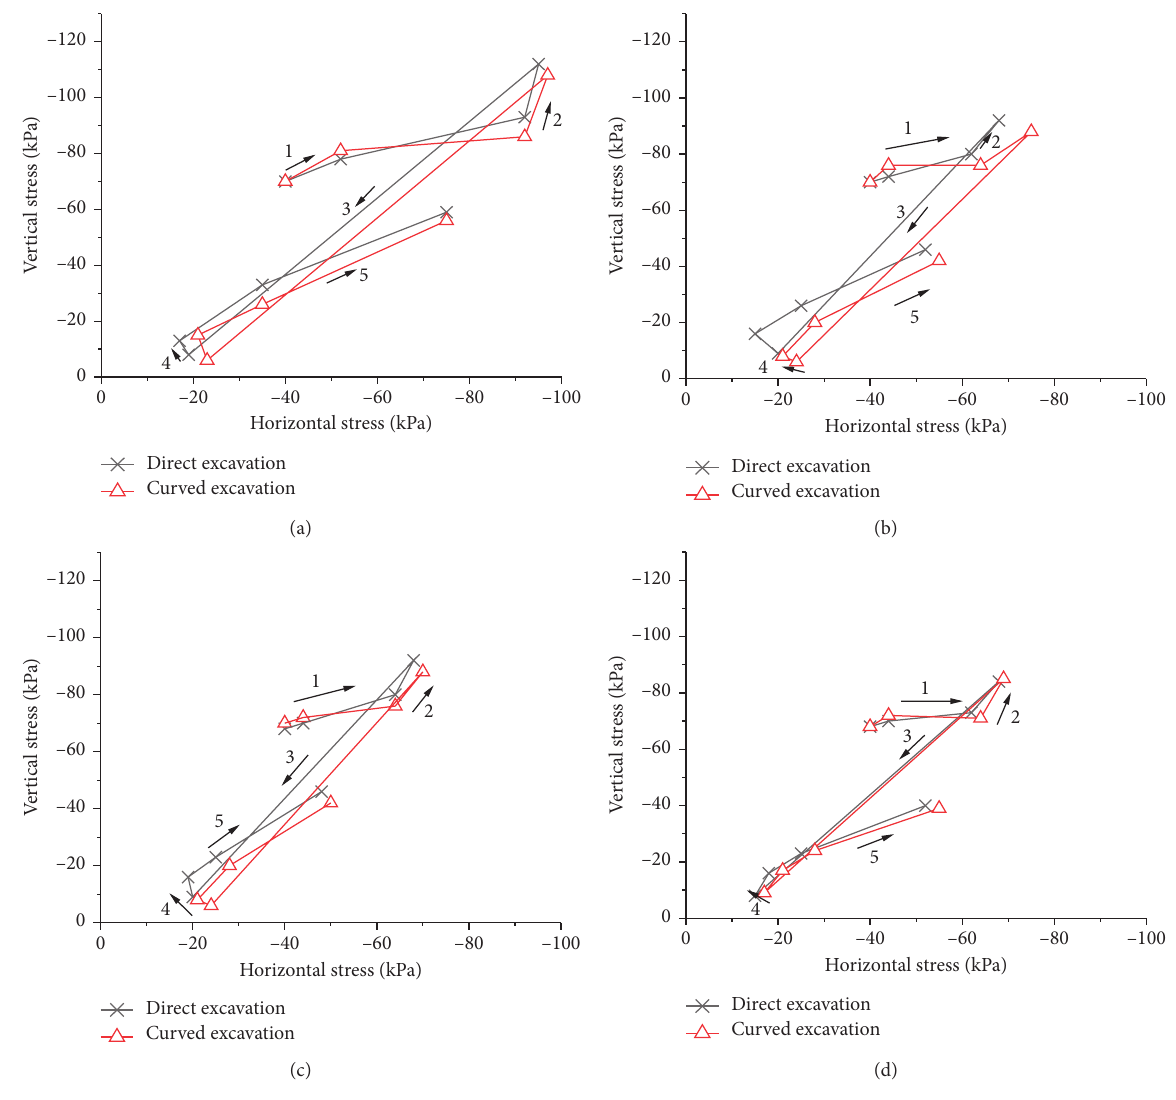
Figure 9: Change of stress path. (a) M1. (b) M2. (c) M3. (d)